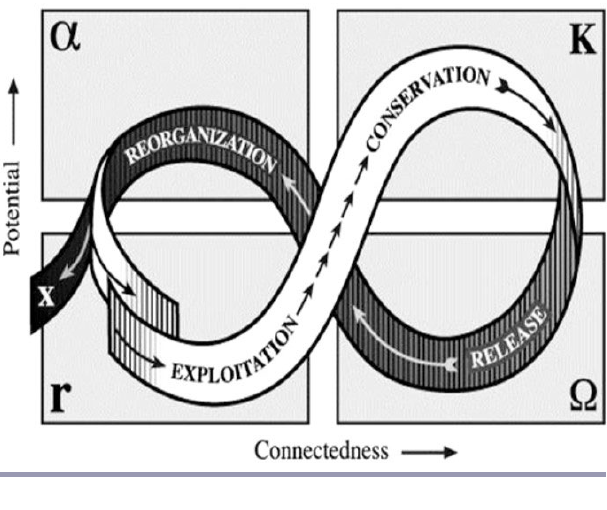
Fig. 1 . The adaptive cycle. Gunderson and Holling (2002).